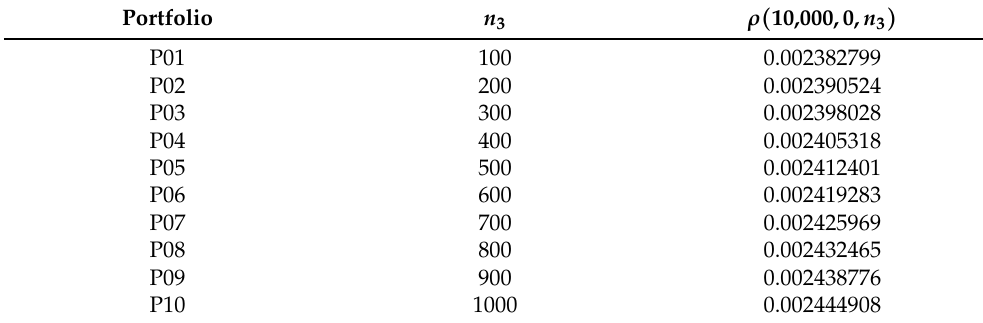
Table 3. Cases 1.2—Impact of the portfolio structure on the risk